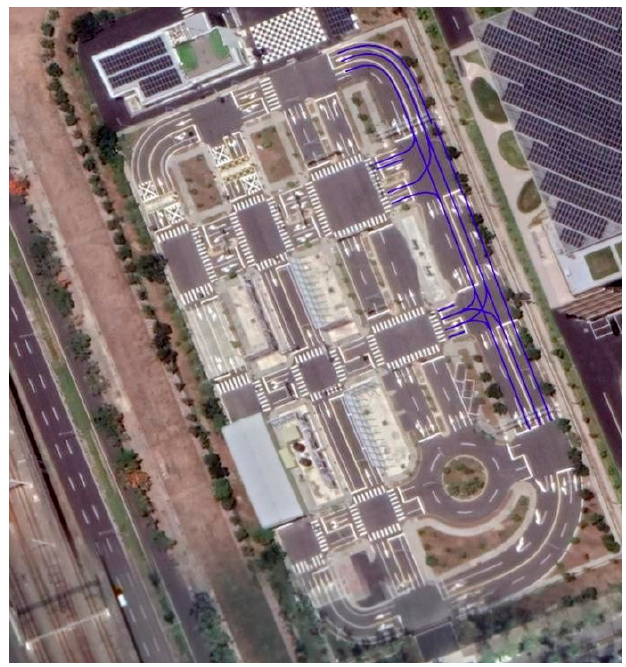
Figure 11. Results in Google Earth (from Google Earth).